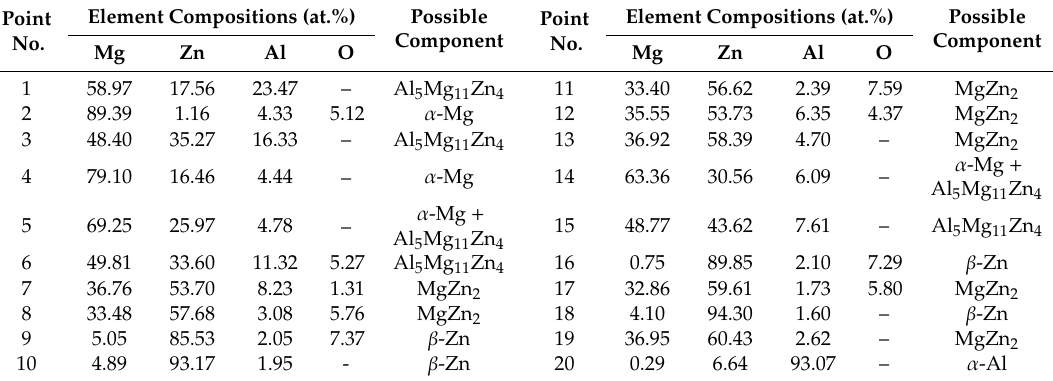
Table 6. EDS analysis results corresponding to the points marked in Figure